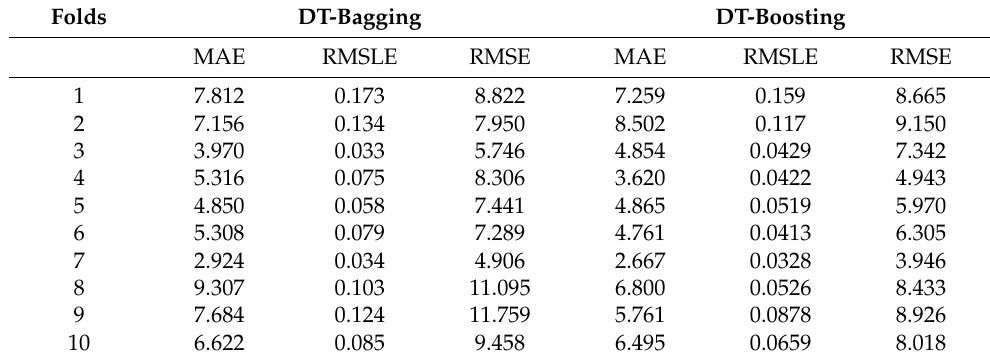
Figure 13. Result of validation; ( a , b ) DT-bagging and DT-boosting; ( c , d ) MLPNN-bagging and MLPNN-boosting; ( e ) random forest; ( f ) gradient boosting. Table 10. Result of K-Fold cross-validation for ensemble